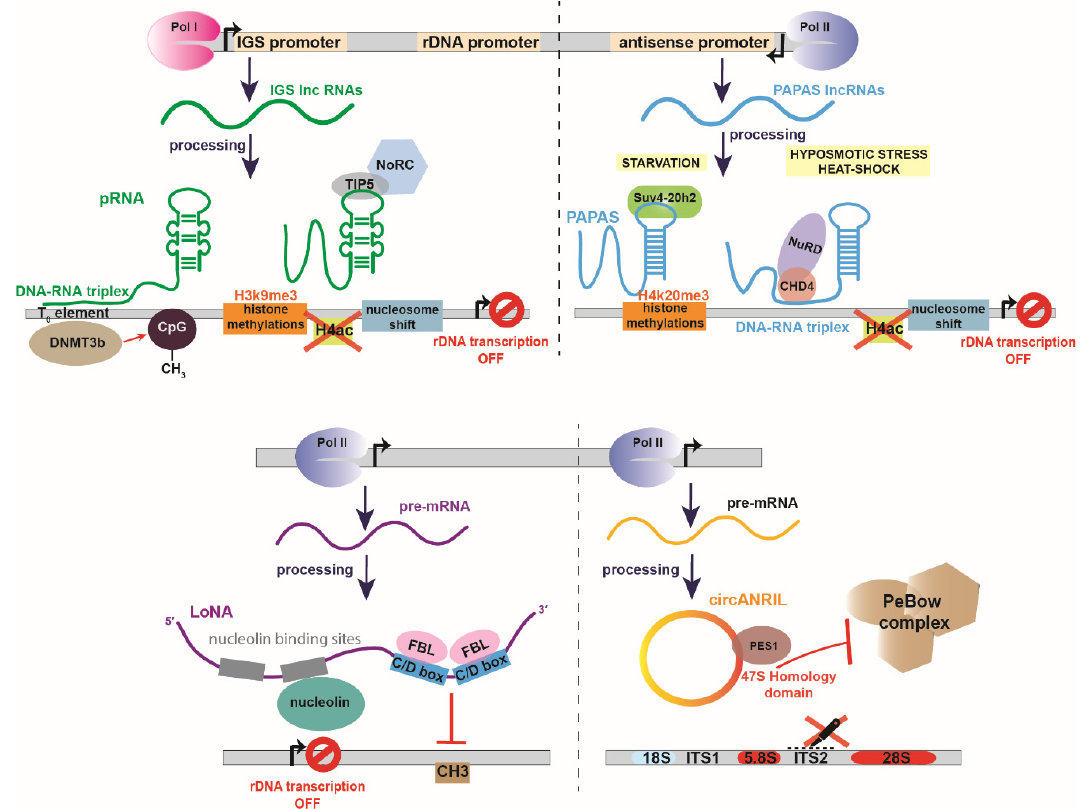
Figure 2. Examples of negative non-coding RNA regulators of rRNA biogenesis. (Top left panel) pRNA is transcribed by RNA polymerase I (Pol I) by an intergenic spacer promoter (IGS promoter). pRNA is a bifunctional lncRNA which 5 ′ end forms a DNA-RNA triplex with the T o element of the rDNA promoter and the methyltransferase DNMT3b which in turn methylates CpG. At its 3 ′ end, pRNA forms a stem loop structure which interacts with TIP5 component of the nucleolar remodeling complex (NoRC) to induce H3K9me3 histone methylation, removal of H4ac acetylation marks and transcription inhibition by nucleosome shift. (Top right panel) Promoter and pre-antisense lncRNAs (PAPAS) are transcribed by RNA polymerase II (Pol II) from rDNA sequence in an antisense orientation. Under starvation conditions PAPAS interact with the histone methyltransferase Suv4-20h2, leading to trimethylation of histone H4 at lysine 20 (H4K20me3) and chromatin condensation. Under hypoosmotic stress or heat-shock, PAPAS interact with CHD4 and the nucleosome remodeling and deacetylase (NuRD) complex and promote histone deacetylatation, nucleosome shifts that inhibit the rDNA transcription. (Bottom left panel) Long nucleolar RNA (LoNA) is a dual-function lncRNA, transcribed by RNA pol II. LoNA contains two nucleolin-binding sequences, one of which is able to bind and suppress nucleolin’s activity. On the 3 ′ end, LoNA contains two C/D box sequences that compete for fibrillarin’s binding with canonical C/D box snoRNPs and suppress the pre-rRNA methylation. (Bottom right panel) CircANRIL is a circular lncRNA transcribed by RNA pol II. CircANRIL bears a homology domain with the 47S pre-rRNA which binds PES1, a component of PeBoW complex. Binding of PES1 by circANRIL suppresses PeBoW formation and inhibits ITS2 cleavage. ITS1 refers to Internal transcribed spacer 1 and ITS2 to Internal transcribed spacer